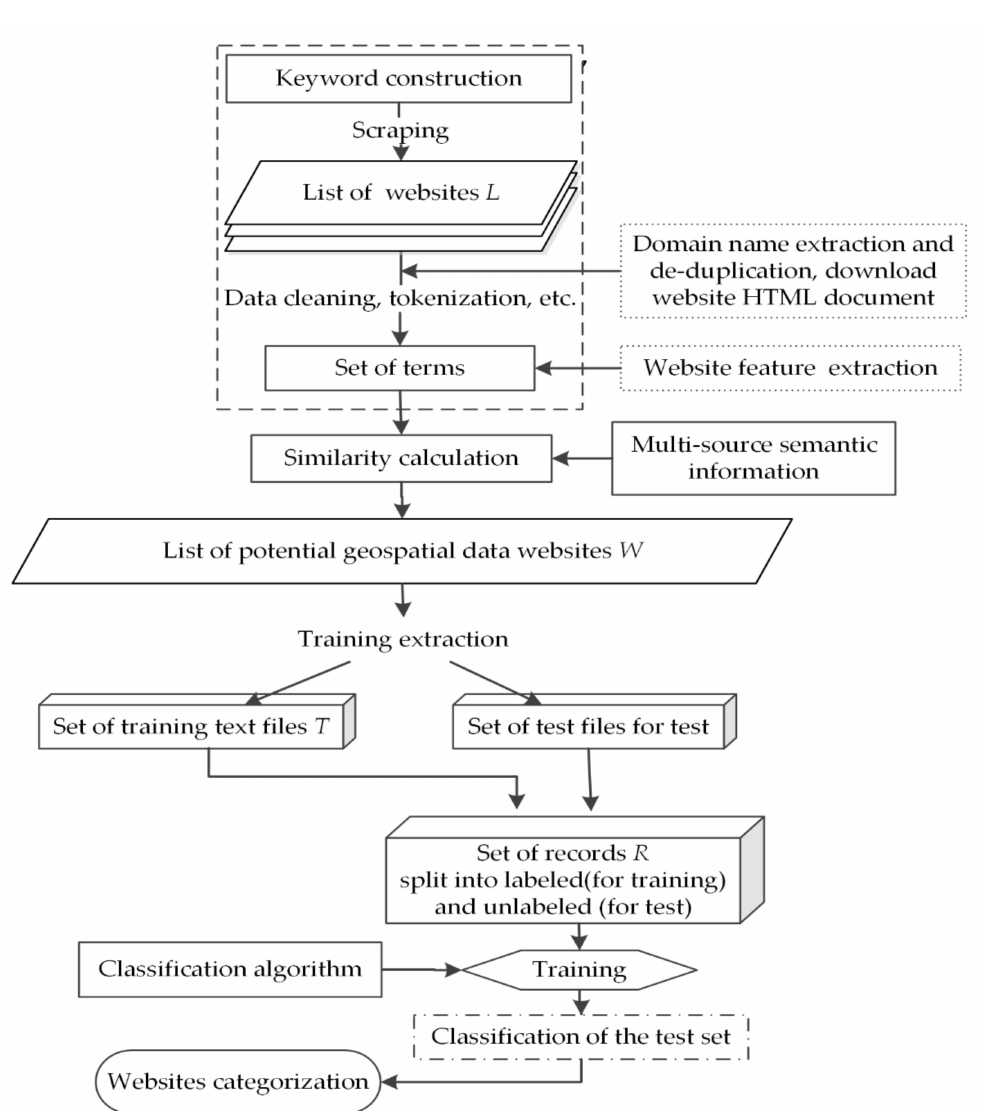
Figure 1. GDSW identification